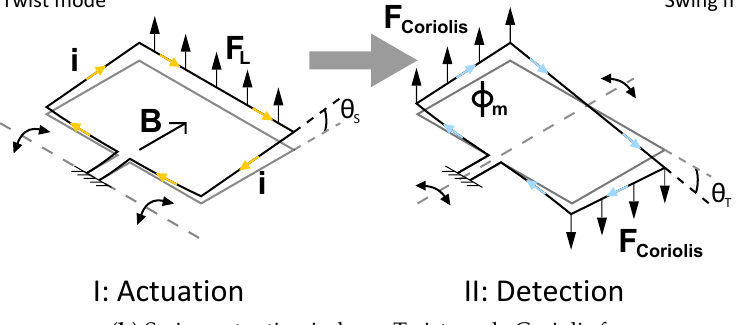
Figure 1. Operation principle of a micro-Coriolis mass flow sensor. I: The channel loop is brought into resonance with actuation angle θ T in ( a ), θ S in ( b ) through Lorentz force F L , resulting from a magnetic field B and an AC current i . II: A mass flow φ m through the channel induces vibration in the detection mode through Coriolis force F Coriolis , resulting in a sensing angle θ S in ( a ), θ T in ( b ). The ratio between the two vibration mode amplitudes is a measure for the